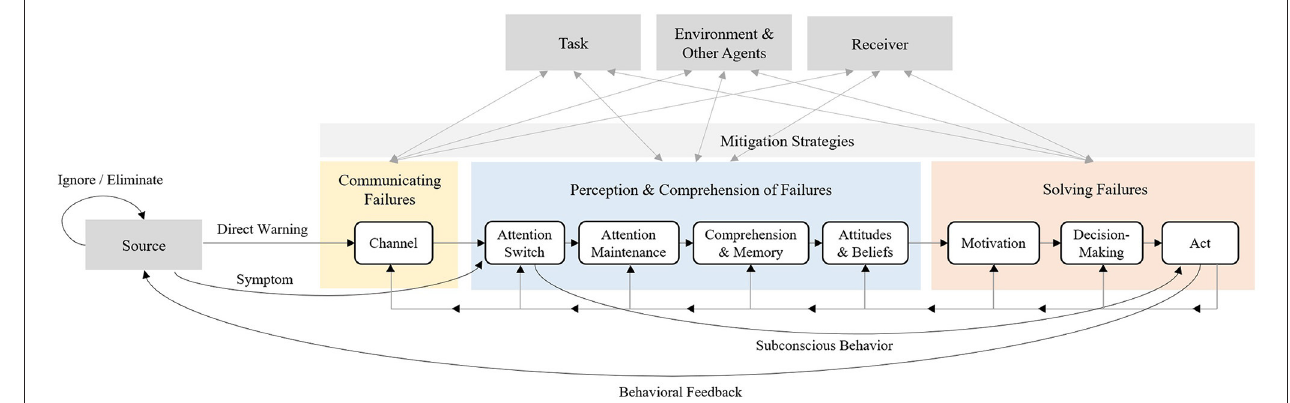
FIGURE 3 | The RF-HIP